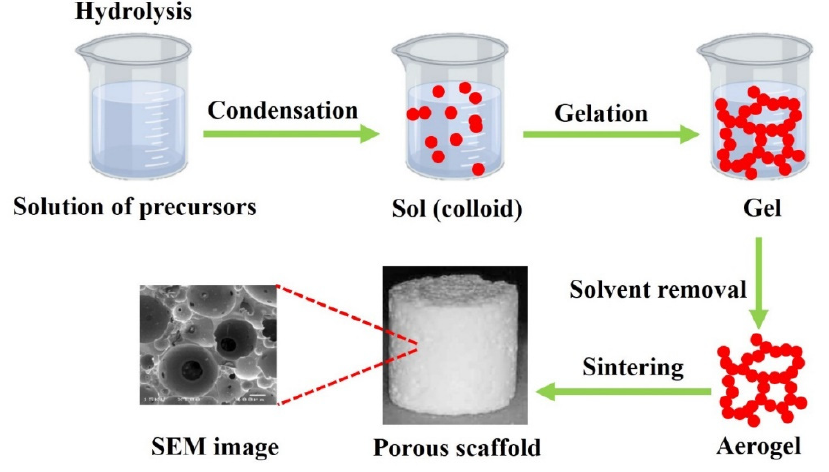
Figure 6. The conventional porous bioglass scaffold fabrication.